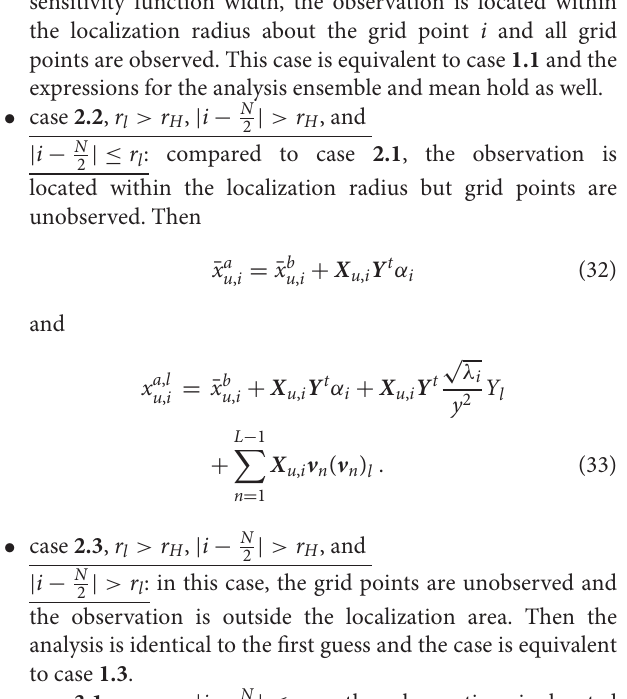
5 (black) and r H 10 (red). (A) Original = = 0.01. All =